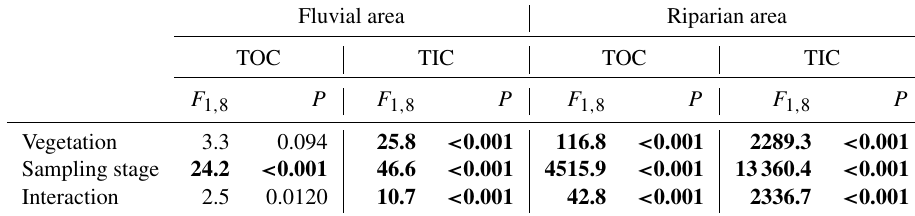
Table A4. ANOVA results for the effects of vegetation (with vegetation vs. without vegetation; between-subject factor), sampling seasons (pre-flooding, during flooding, post-flooding), and interaction effects on total organic carbon (TOC) and total inorganic carbon (TIC) in two positions (fluvial area vs. riparian area). F and P (significance) values are